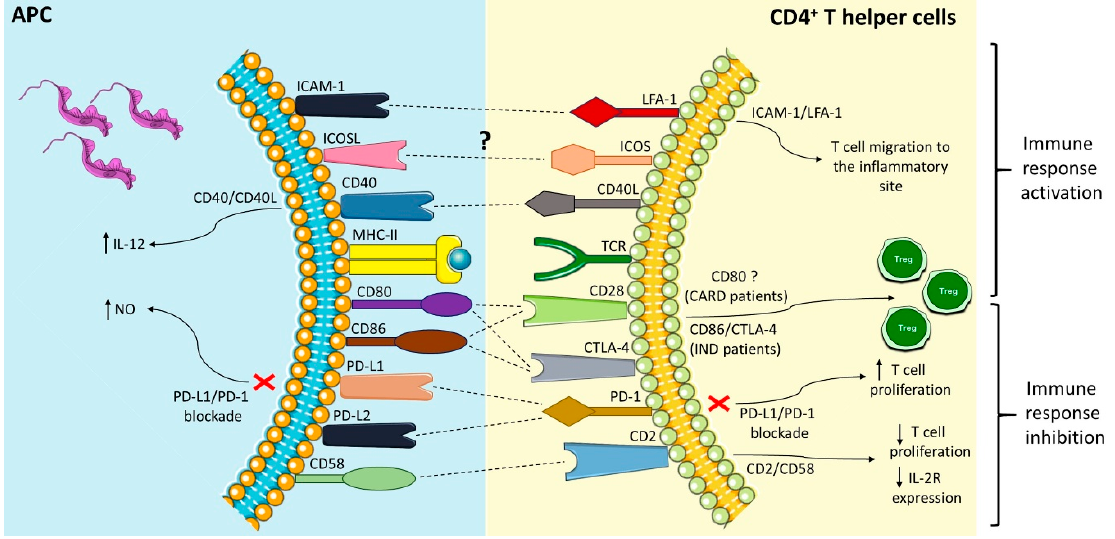
Figure 1. Interactions between co-stimulatory molecules present on professional antigen-presenting cell (APC) with CD4 + T helper cells and its possible role in Chagas disease. Dashed lines (---) represent the specific interaction between the receptors.